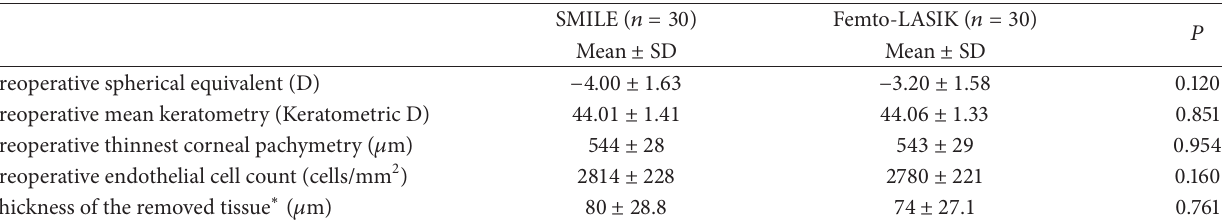
Table 1: Preoperative